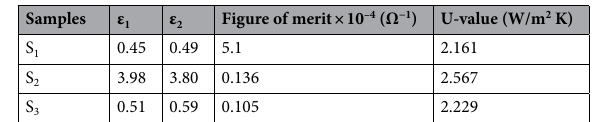
Table 3. Emissivity, FOM, and U-value of all samples.